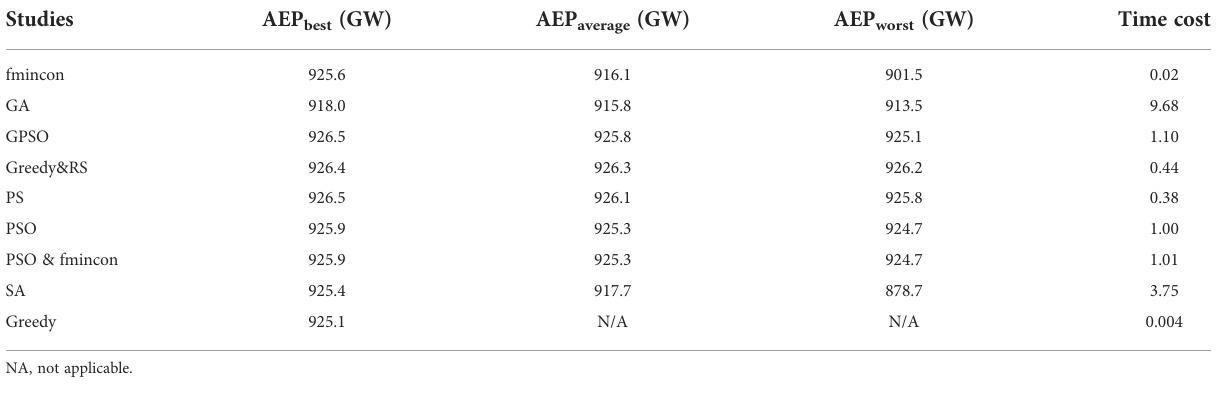
TABLE 6 Comparison of optimal solutions of different